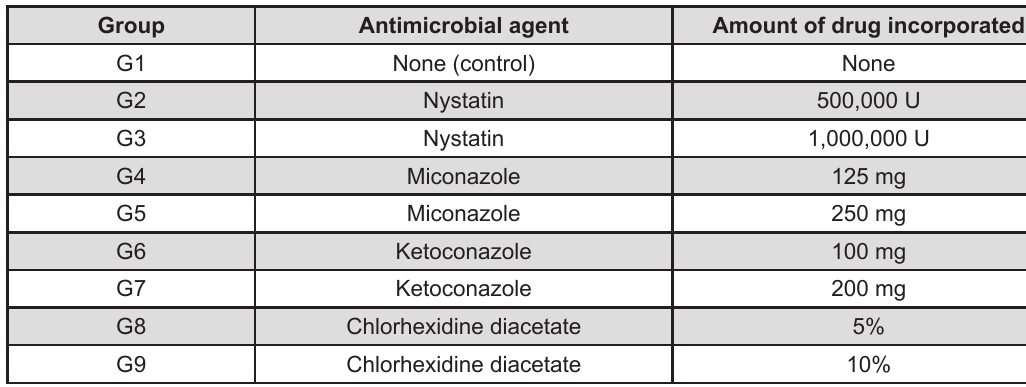
Figure 2- Drug dosages incorporated into the resilient liner powder in all experimental